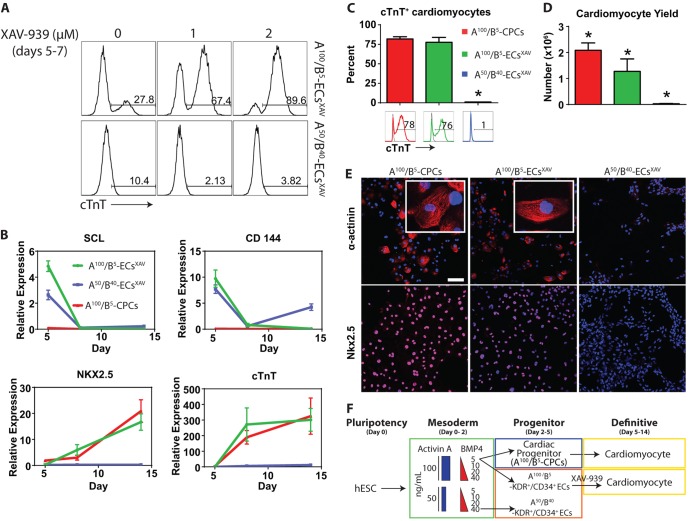
Inhibiting Wnt/β-catenin signaling redirects A100/B5 ECs but not A50/B40 ECs into the cardiac fate with high efficiency. (A) Flow cytometry analysis of cTnT+ cells from ECs treated with increasing doses of XAV-939 between days 5 and 7 of differentiation. (B) qRT-PCR analysis of SCL, VE-cadherin (CD144), NKX2.5 and cTnT between differentiation days 5 and 14, comparing the lineage potential from day 5 cultures derived from A100/B5 CPCs, A100/B5 ECsXAV and A50/B40 ECsXAV. (C) Percentage of cardiomyocytes assessed by flow cytometry for the myofilament protein cTnT among day 14 cells. (D) Cardiomyocyte yield generated from A100/B5 CPCs, A100/B5 ECsXAV and A50/B40 ECsXAV. (E) Immunohistochemistry for α-actinin and NKX2.5 in day 14 cells generated from A100/B5 CPCs, A100/B5 ECsXAV and A50/B40 ECsXAV. Scale bar: 100 µm. (F) Schematic illustrating that A100/B5 CPCs and A100/B5 ECsXAV are lineage biased to the cardiac fate compared with A50/B40 ECsXAV. n=5-6 replicates per sample. *P<0.05 versus all other groups.